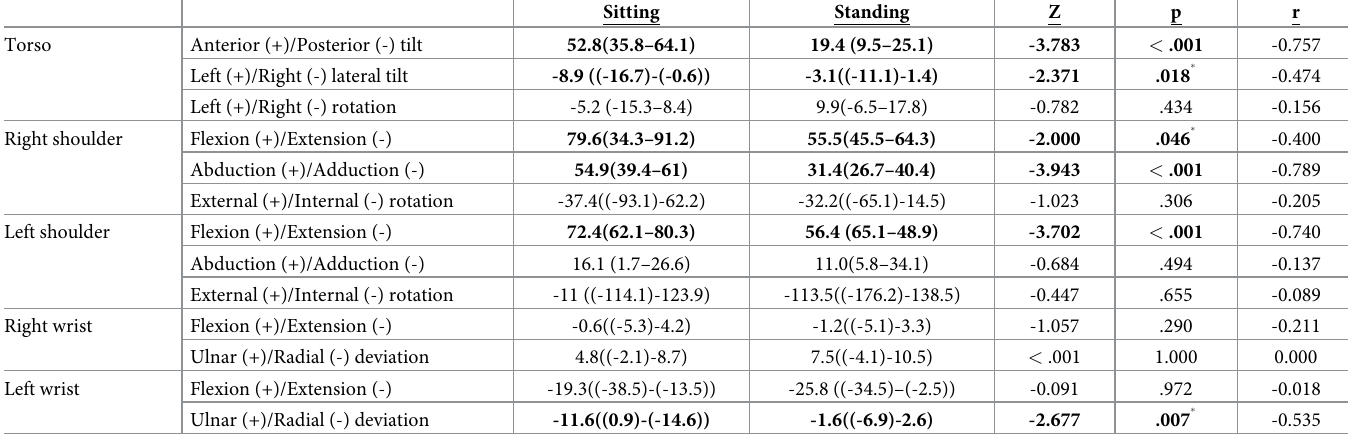
Table 2. Median and interquartile range of mean joint angles (in degrees) while playing in a sitting and standing positions. Sitting